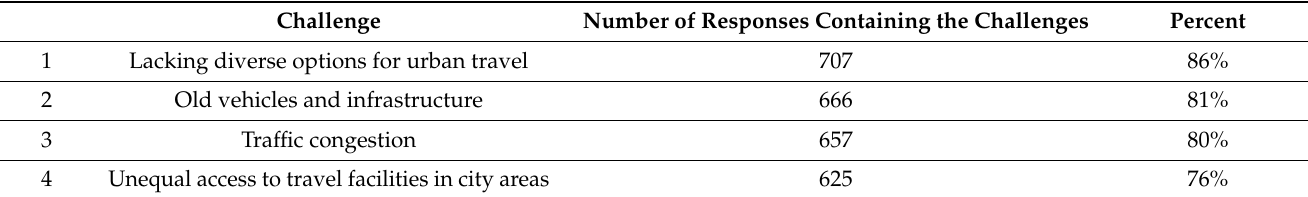
Table 9. Challenges affecting urban travel behavior in the Tehran metropolitan